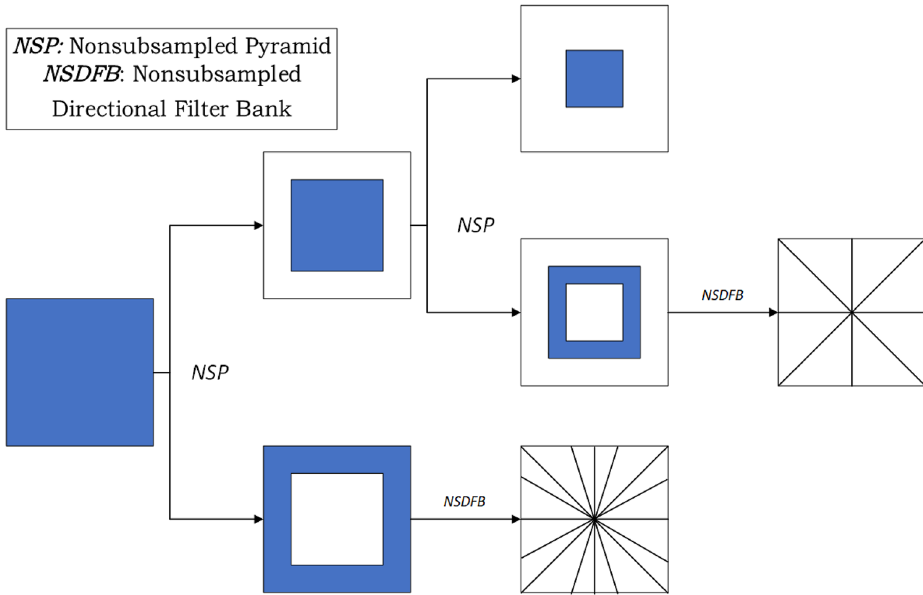
Figure 4. Structure of nonsubsampled contourlet